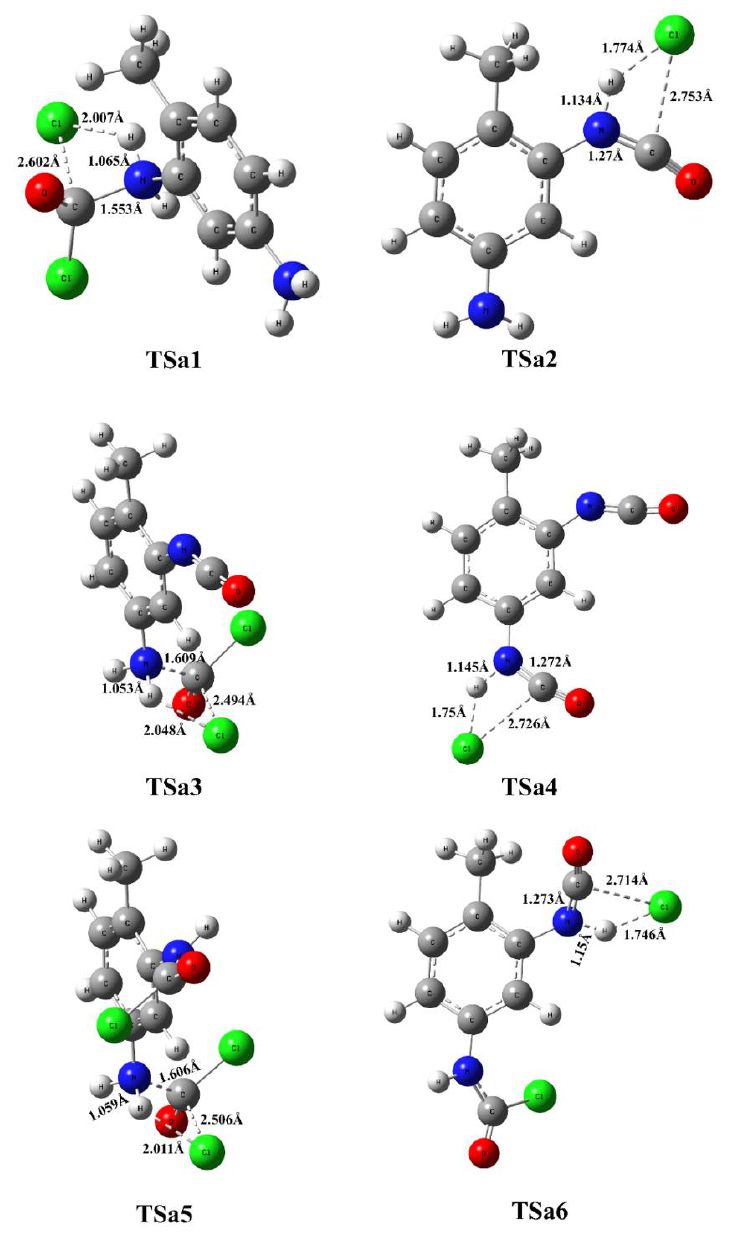
Figure 5. Transition-state structures for the phosgenation of 2,4-TDA in gas phase. In the case of “stepwise phosgenations”, the carbamic chloride intermediate IMa1 or Imb1 undergoes HCl-elimination resulting in the formation of the first isocyanato group, namely 3-isocyanato-4-methylaniline (IMa2) and 5-isocyanato-methylaniline (Imb2), re- spectively. Their relative energies (IMa2 ( ∆ E 0 = − 51.3 kJ/mol), Imb2 ( ∆ E 0 = − 51.8 kJ/mol)) are higher than the intermediate of the previous step (IMa1 ( ∆ E 0 = − 69.2 kJ/mol), Imb1 ( ∆ E 0 = − 71.1 kJ/mol)). Therefore, the corresponding transition states (Tsa2 and TSb2) lie high ( ∆ E 0 = 43.6 kJ/mol for Tsa2 and ∆ E 0 = 44.6 kJ/mol for TSb2), which can be under- stood by looking at the drastically elongated C-Cl bond in the transition-state structures in Figure 5 (2.753 Å for Tsa2) and Figure 6 (2.750 Å for TSb2). This HCl elimination step is the most energy-consuming one in the “stepwise phosgenations” mechanism. Considering the further step either from IMa2 ( → Tsa3 → IMa3 → 2,4-TDI) or Imb2 ( → TSb3 → Imb3 → 2,4-TDI), it turned out that the transformation of the second amine group into isocyanate showed similar energy profile as the first